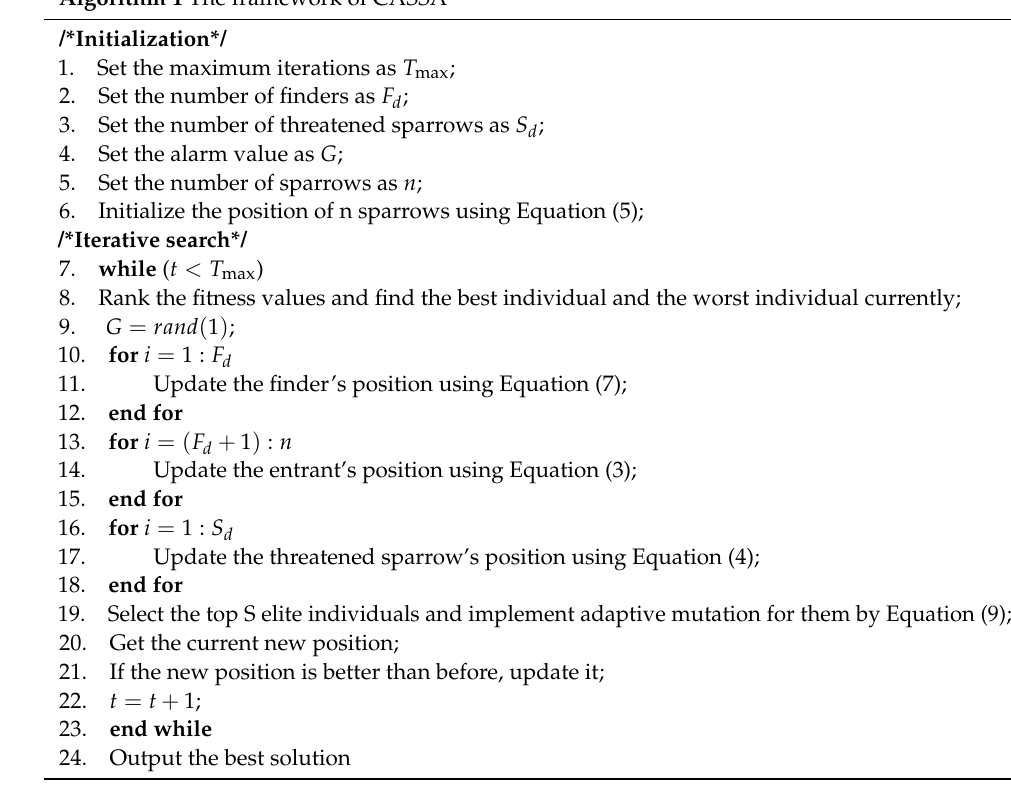
Algorithm 1 The framework of